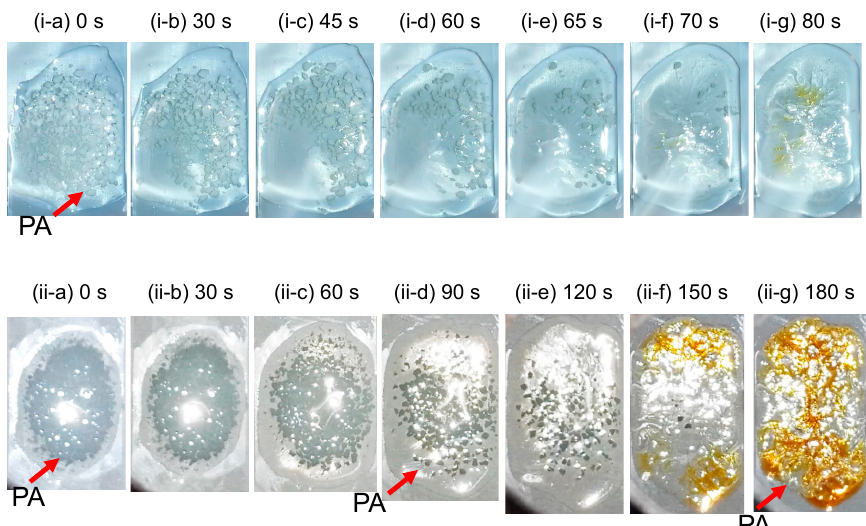
Figure 2. Sequential on-site photography of the curing of (BADGE + PA + EM) adhesives {Bisphenol-A diglycidyl ether (BADGE), Phthalic anhydride (PA), 2-Ethyl-4-methylimidazole (EM)} ( i ) by microwave heating for times (a) through (g) of 0 to 80 s and ( ii ) by electric furnace heating for times (a) through (g) of 0 to 180 s.